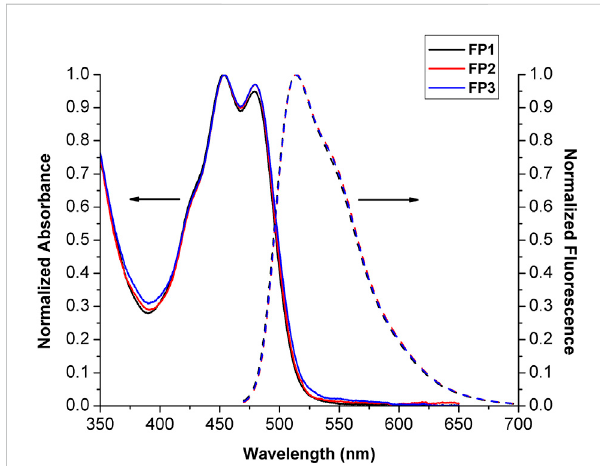
FIGURE 1 Normalized absorbance and emission spectra ( λ ex = 452 nm) of probes FP1 – FP3 (10 μ M) in MeOH. The absorbance and emission spectra are drawn with solid and broken lines, respectively.